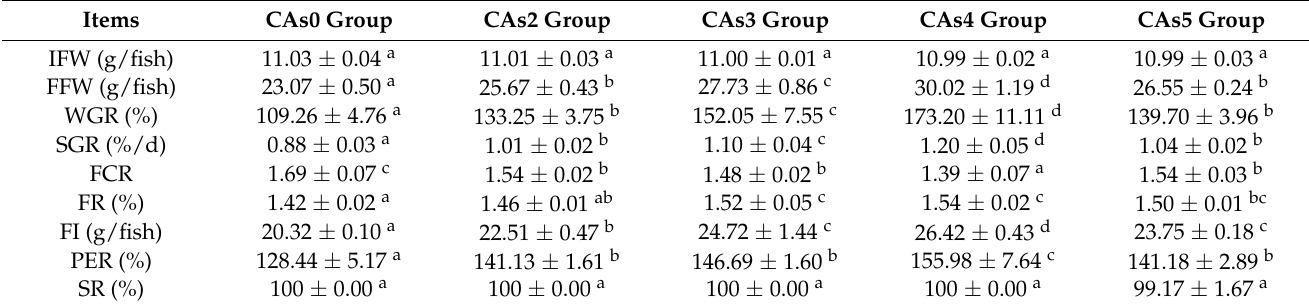
Table 1. Growth performance of juvenile American eel in different CAs supplementation groups.